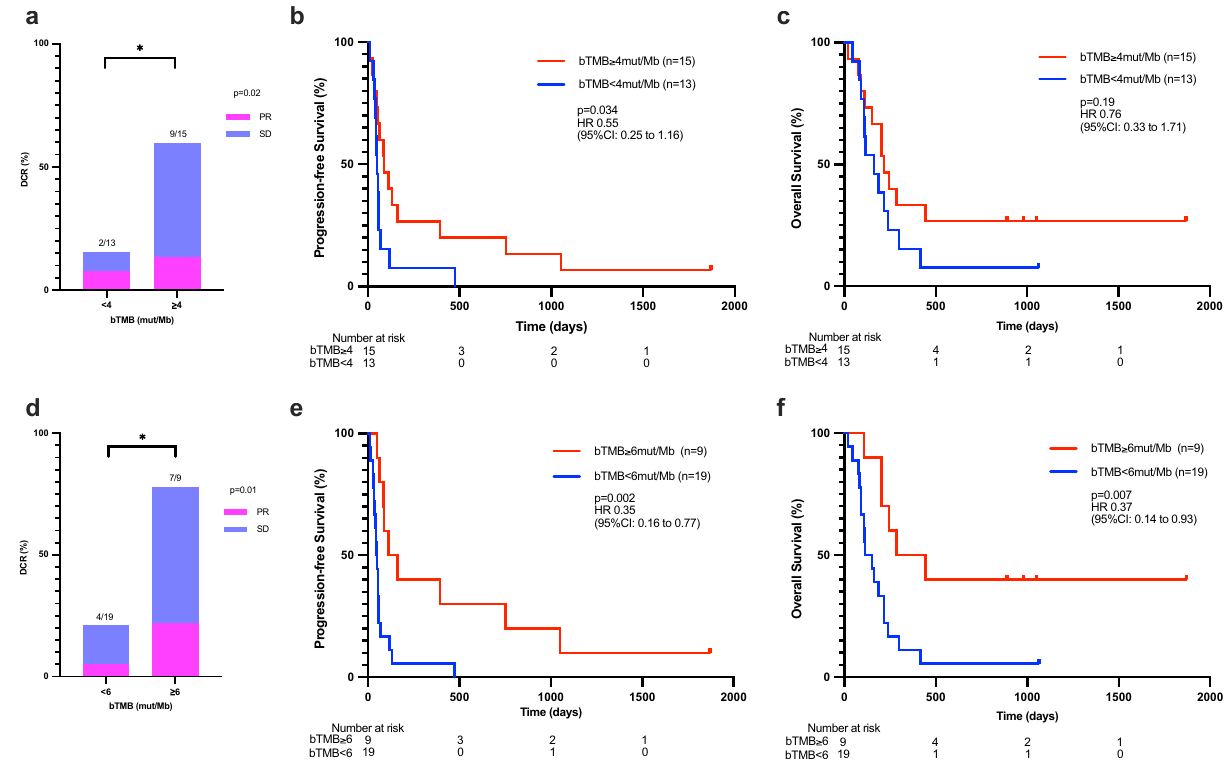
Figure 3. The association of blood tumor mutation burden (bTMB) with clinical outcome of gastric cancer patients received nivolumab monotherapy. Disease control rate (DCR, a ), and Kaplan–Meier estimates of progression-free survival (PFS, b ), as well as overall survival (OS, c ) of patients stratified by bTMB of 4 mut/Mb. Disease control rate (DCR, d ), and Kaplan–Meier estimates of PFS ( e ), as well as OS ( f ), of patients stratified by bTMB of 6